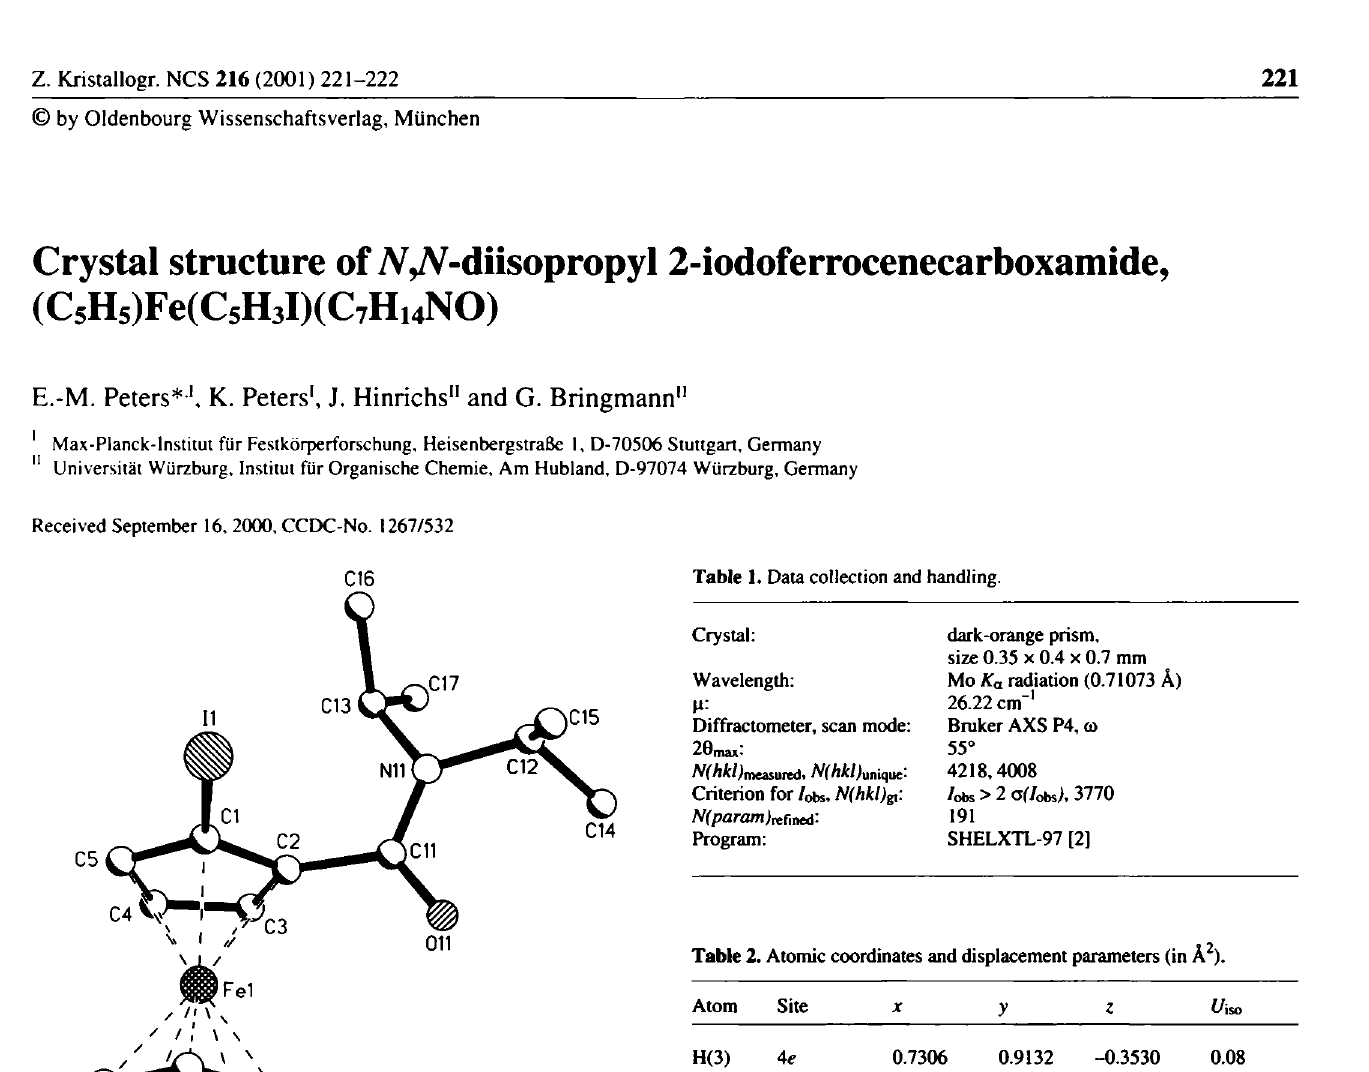
Table 2. Atomic coordinates and displacement parameters (in A 2